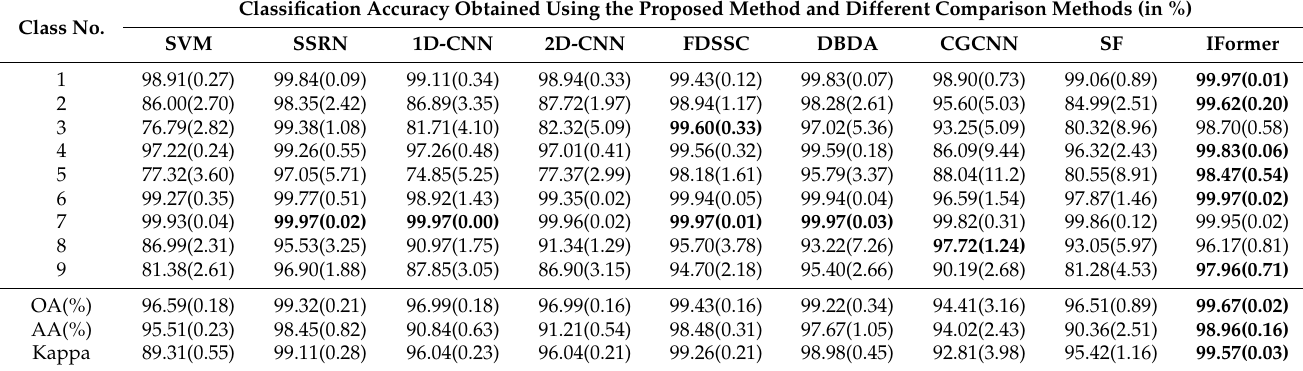
Table 8. Accuracy comparison of different methods on LK